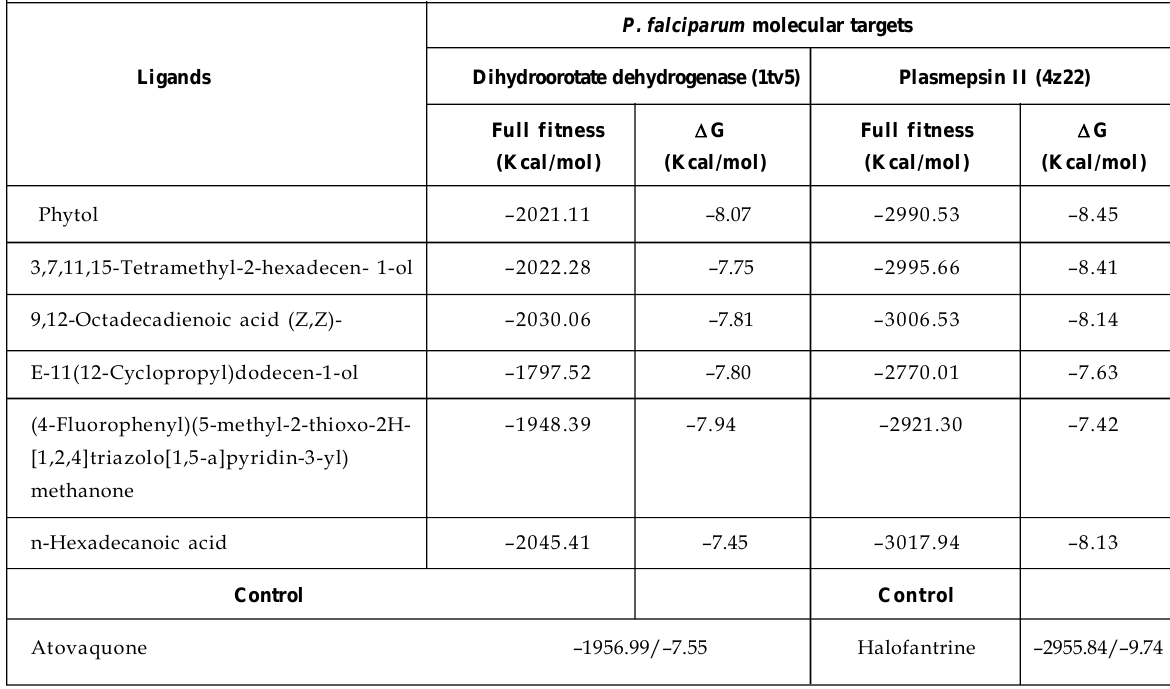
Table 6: Docking result of P. falciparum molecular drug targets